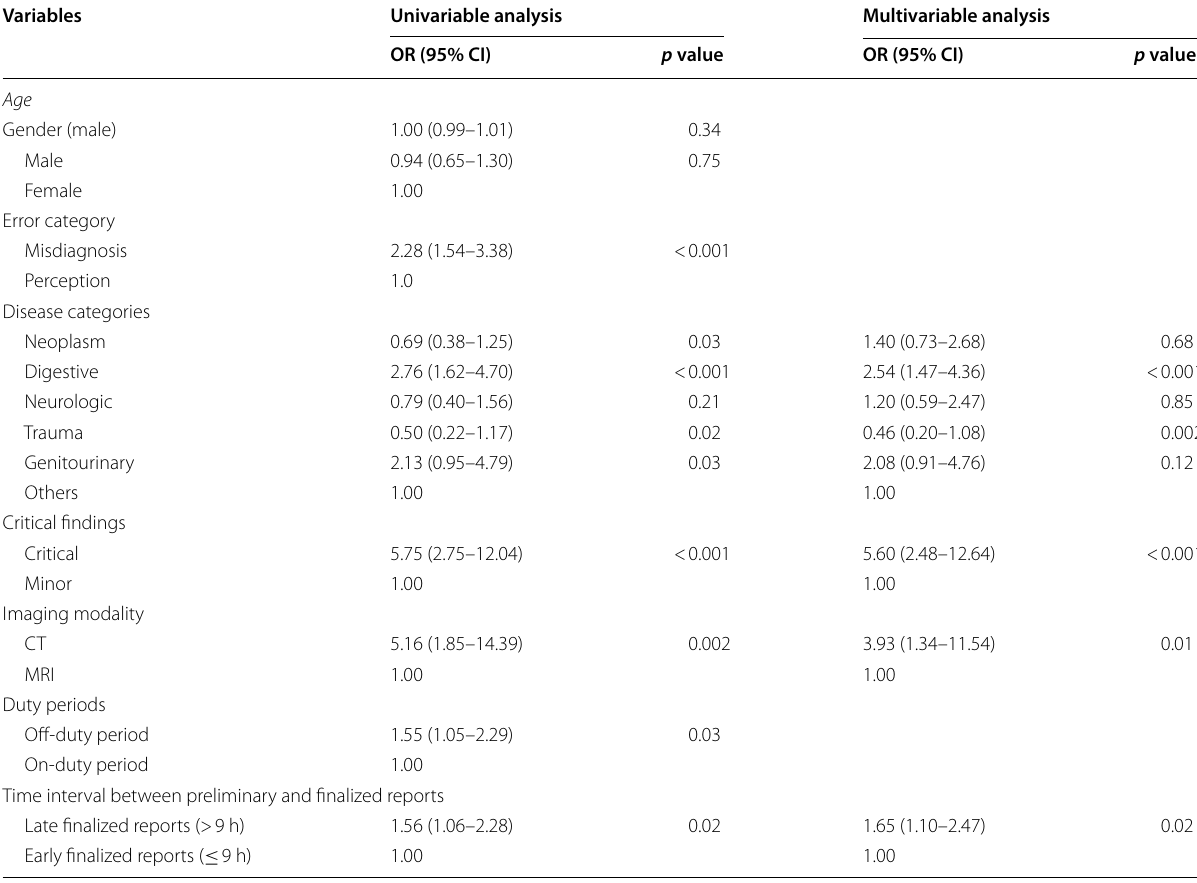
Data are shown as odds ratios with 95% confidence intervals in parentheses CT computed tomography, CI confidence interval, MRI magnetic resonance imaging, OR odds ratio